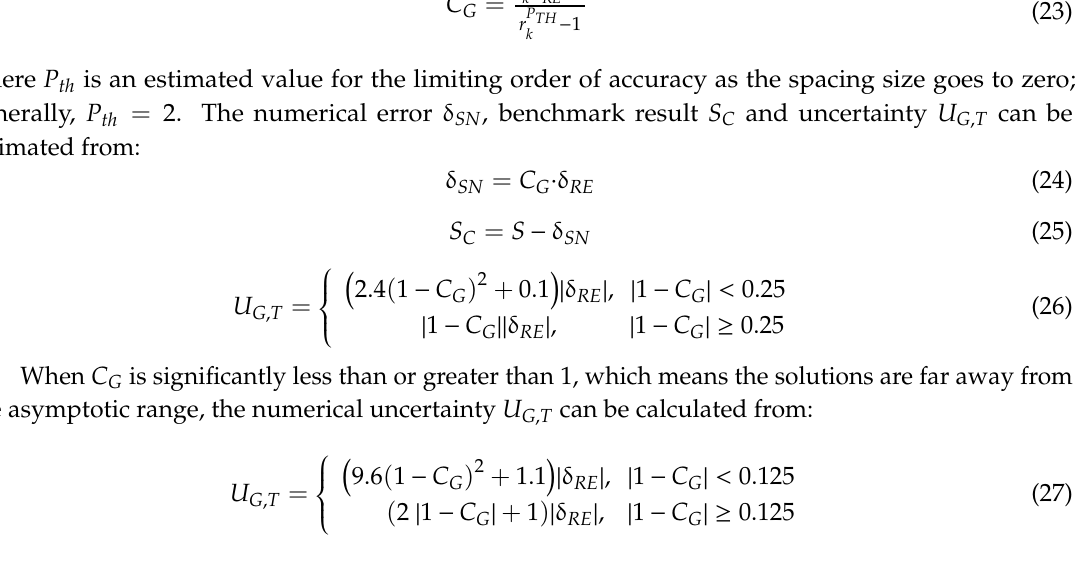
Table 5. Total resistance coefficients of different grid cases of the 1:31.6 scaled model.